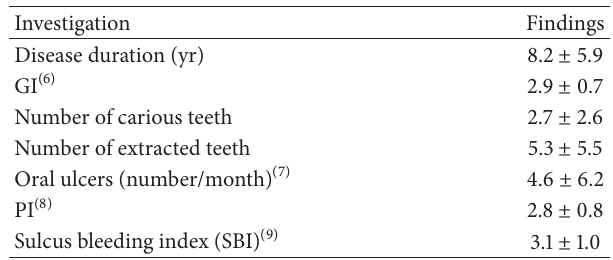
Table 4: Periodontal test outcomes of Behc¸et disease